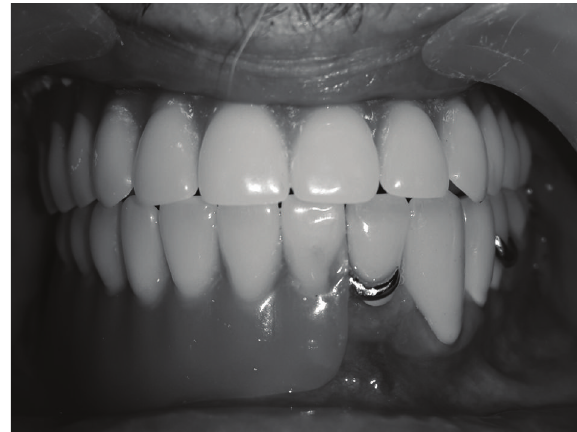
Figure 7: Frontal view with definitive prostheses in maxilla and mandibula.